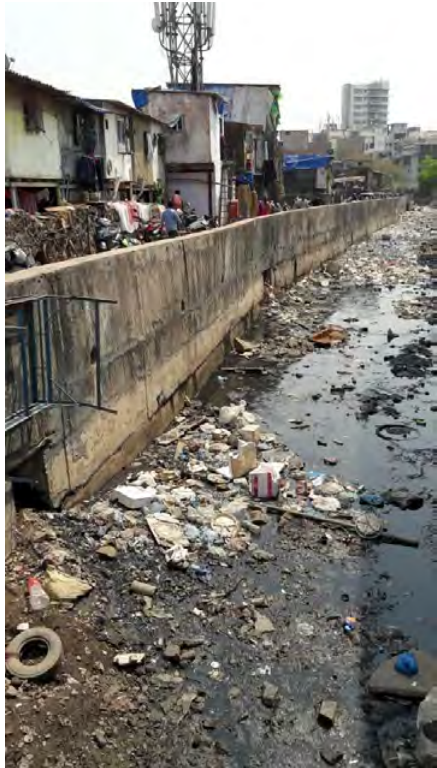
Figure 4. Gazdar Bandh slum site covered during field study